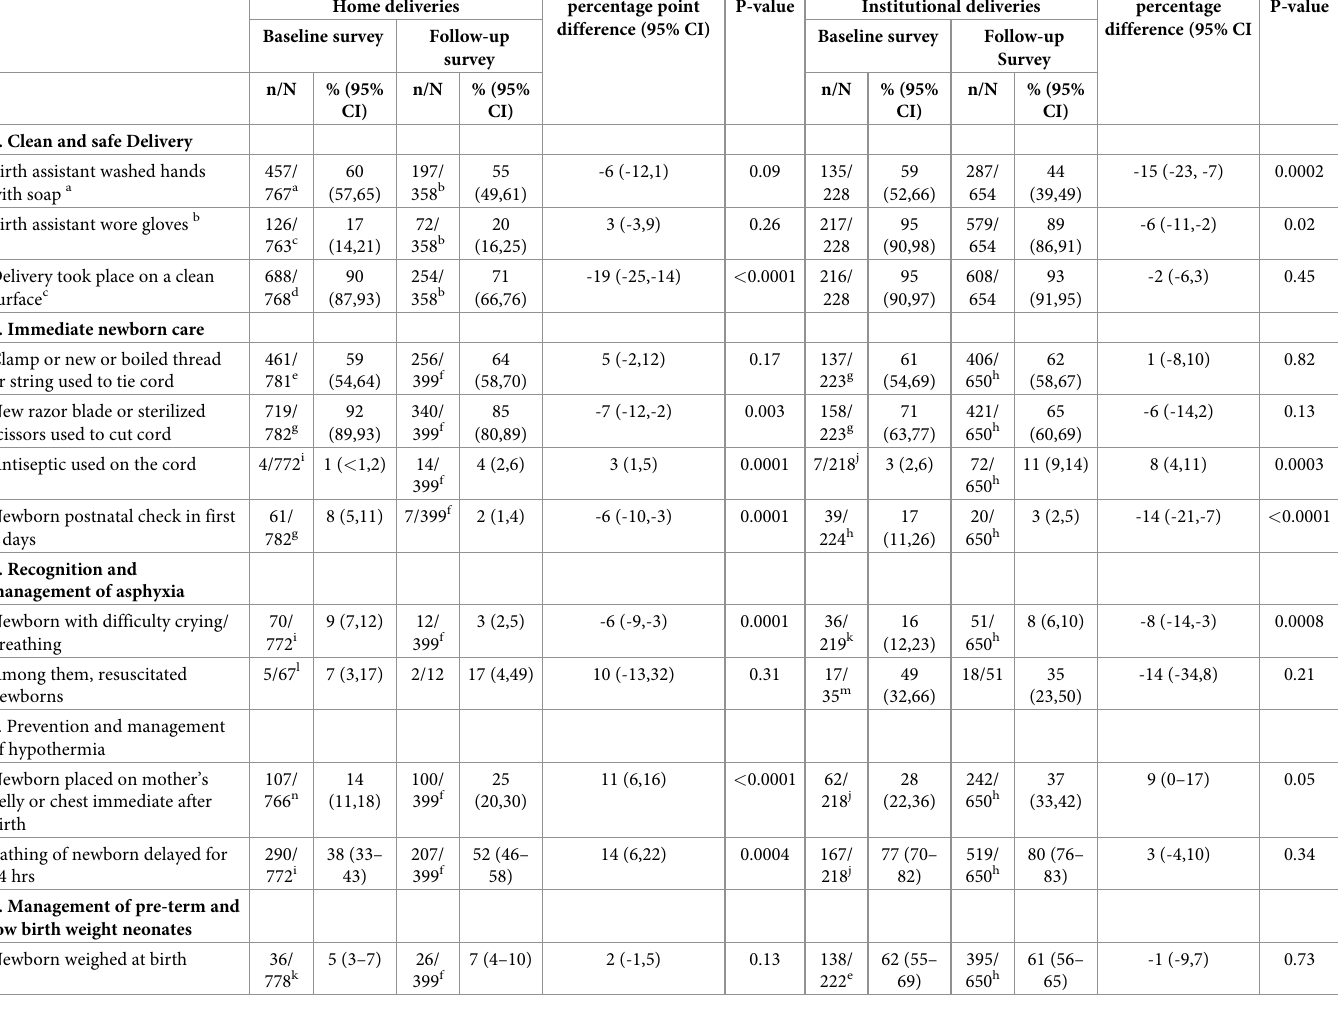
Table 4. Clean and safe delivery, immediate newborn care and complications management for mothers who had a birth in the 3–15 months prior to the baseline (October–December 2013) and follow-up (November-December 2017)